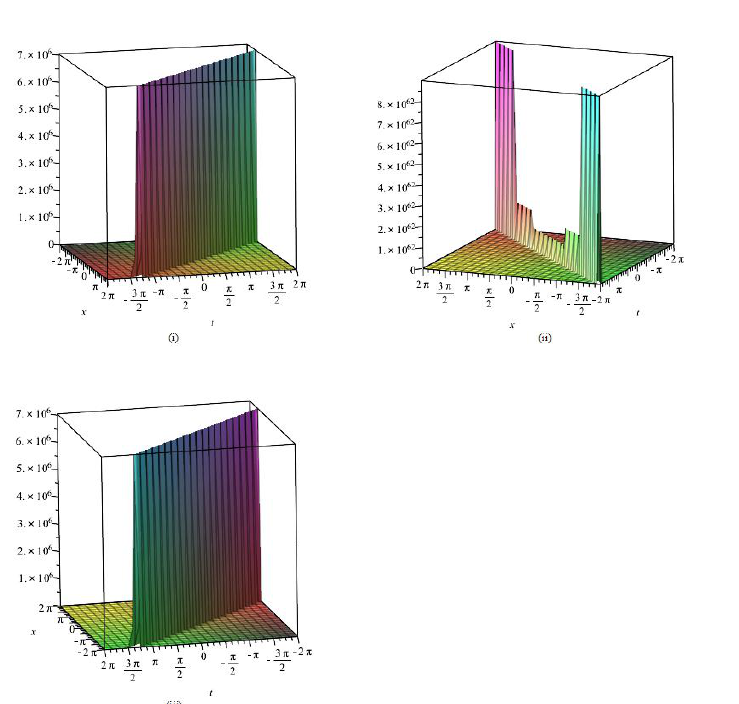
Figure 3. The 3D profiles of solution u s ,1 ( x + ν t ) of Equation (1) corresponding to ( i ) x 0 = 1, t 0 = 1,